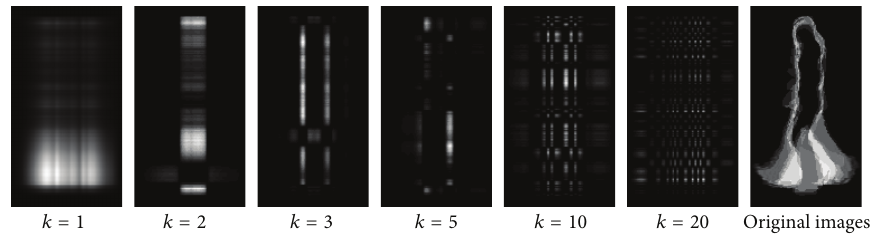
Figure 3: The reconstructed subimages ( 𝑘 = 1, 2, 3,5, 10, 20 ) and the original